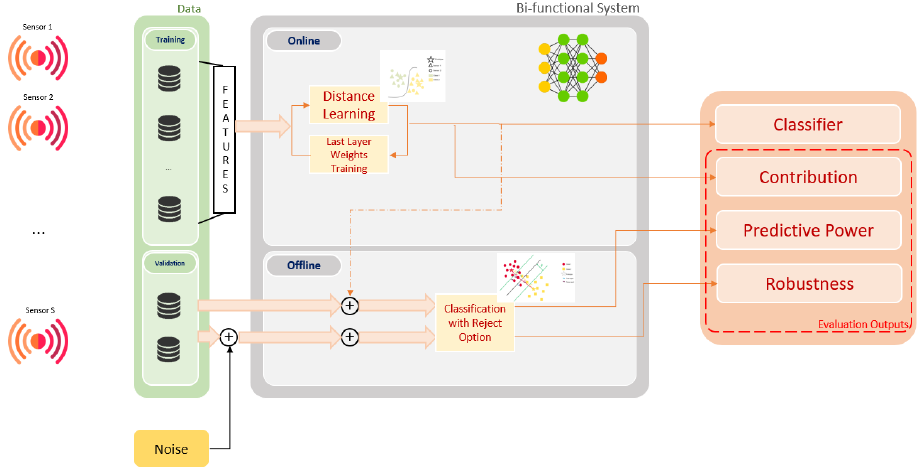
Figure 1. Bi-functionality of the proposed approach: Classification and